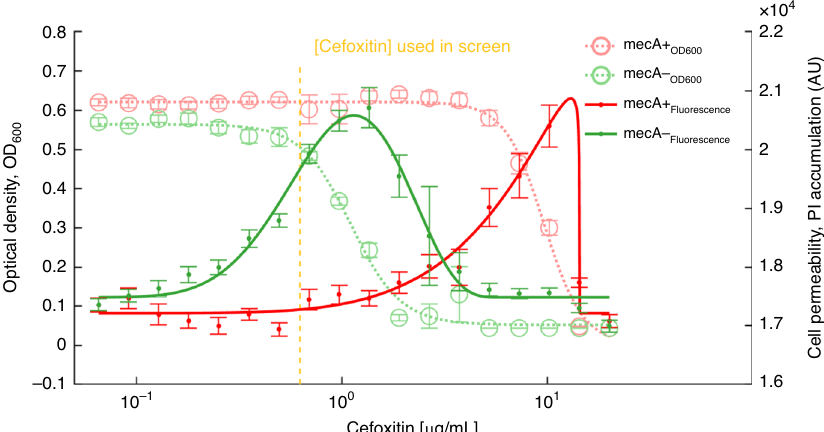
Fig. 4 Reduced mecA + cell-envelope permeability at subinhibitory cefoxitin concentrations. Accumulation of propidium iodide (PI, 6 μ g/mL) in mecA + and mecA − strains. The mean fl uorescence intensity (544 ex/620 em) and optical density at 600 nm (OD 600 ) of ten measurements after 2.5 – 5 h of growth of six replicates of mecA + and mecA − cells separately following PI addition as a function of a cefoxitin gradient. Error bars are standard errors of the mean. Yellow dashed line represents the cefoxitin concentration used in the assay. S. aureus cells become more permeable around their cefoxitin minimal inhibitory concentration (MIC), creating a concentration range of increased cell-envelope permeability of mecA − , but not mecA + . Source data are provided as a Source Data fi